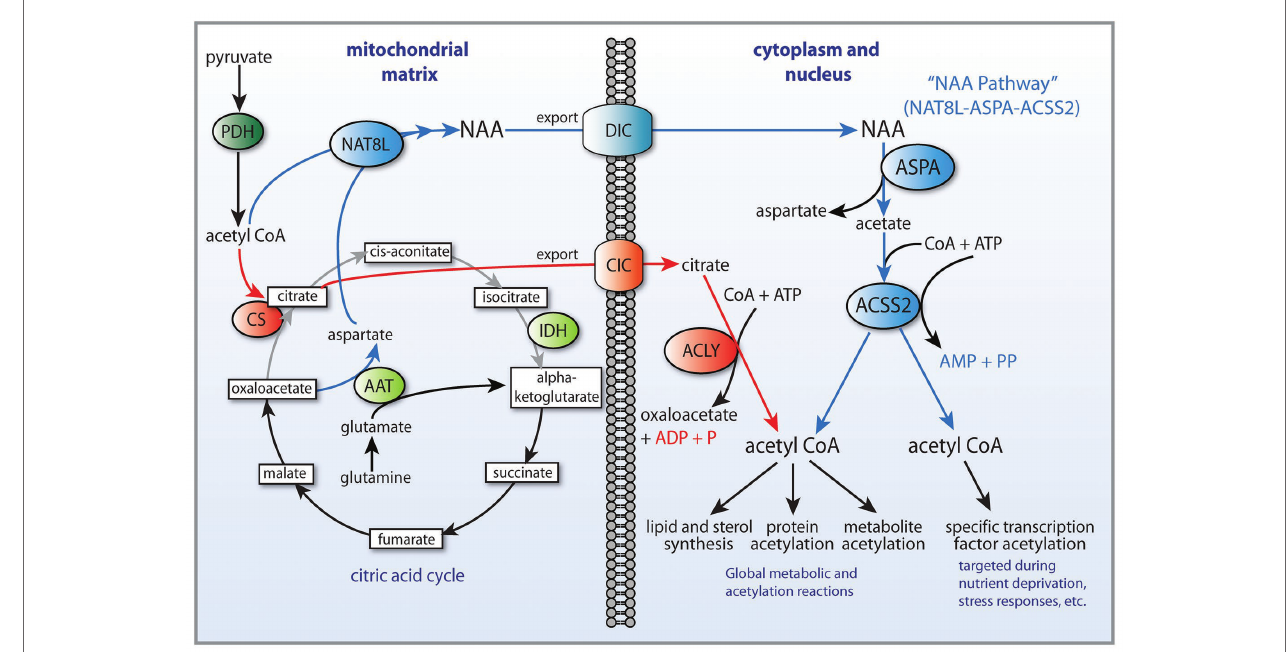
FIGURE 6 | NAA as a selective, alternative cytoplasmic and nuclear acetyl-CoA source. Reduced citrate synthase activity in cancer cells may result in increased NAA synthesis and export from mitochondria. Citrate (red pathway) and NAA (blue pathway) are synthesized from acetyl-CoA in cancer cell mitochondria. Both citrate and NAA are exported from mitochondria to the cytoplasm. The transporter that moves NAA out of the mitochondrial matrix is not known, but the most likely candidate is the dicarboxylate transporter (DIC). Citrate is converted in the cytoplasm into acetyl-CoA, which can then be used for lipid synthesis as well as protein acetylation reactions in the cytoplasm and nucleus. NAA represents an alternative pathway that may allow for transport of acetate groups out of mitochondria, especially under hypoxic conditions when citrate synthase activity is reduced. The portion of the citric acid cycle between citrate and alpha ketoglutarate is reduced (gray lines), and the enzyme aspartate aminotransferase supplies alpha-ketoglutarate from glutamine via glutamate (glutaminolysis). After synthesis, NAA is transported to the cytoplasm and is converted to acetate and aspartate by ASPA. Subsequently, acetate plus CoA are converted to acetyl-CoA by ACSS2. This may represent a salvage pathway for delivering acetyl-CoA from cancer cell mitochondria under hypoxic conditions, when citric acid cycle and citrate synthase activities are reduced. Additionally, ACSS2 provides for a pathway to specific transcription factor acetylation by its selective complex formation with certain transcription factor complexes such as hypoxia inducible factor 2 α (Chen et al., 2015). AAT, aspartate aminotransferase; ACSS2, acyl coenzyme A synthetase short-chain family member 2; ACLY, ATP-citrate lyase; ASPA, aspartoacylase; CS, citrate synthase; CIC, citrate carrier; DIC, dicarboxylate transporter (SCL25A10); IDH, isocitrate dehydrogenase; PDH, pyruvate dehydrogenase; and NAT8L, aspartate N-acetyltransferase (aka NAA